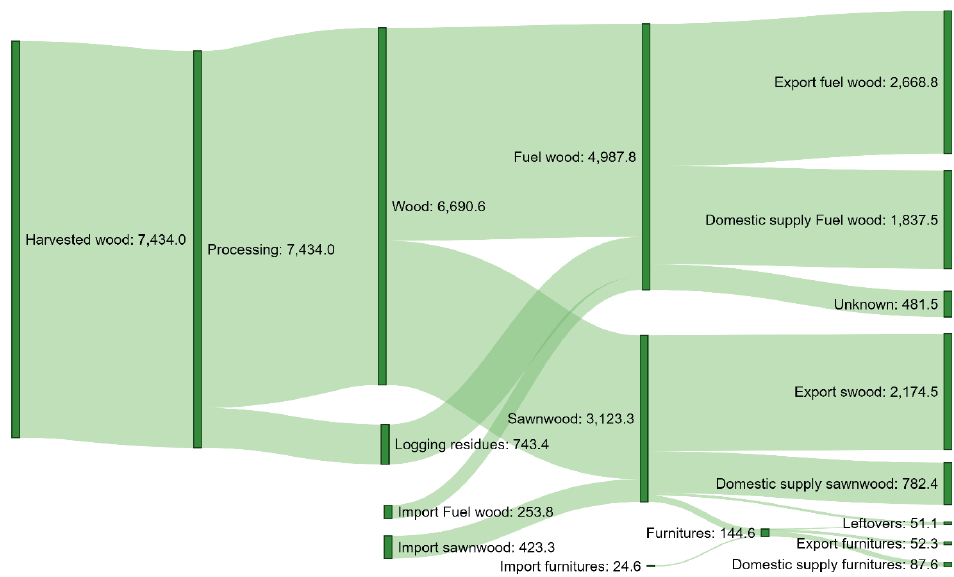
Fig. 5. Sankey diagram for bioresource flows of base scenario in 2015 in the forestry sector, thousand tons. The main flows of final forestry products in 2015 are fuelwood for domestic supply and export. Almost the rest of the products and 2 nd place by produced amount makes wood-based panels (sawn wood) for domestic supply and export. Also, furniture is mainly produced for domestic supply and